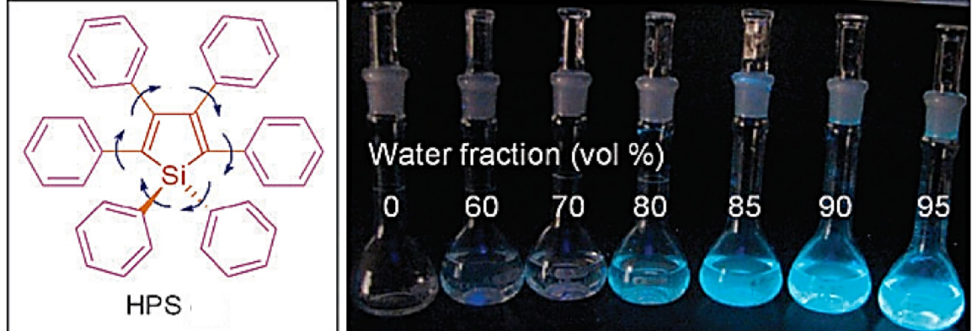
Figure 2. Photograph of hexaphenylsilole (HPS) representing aggregation induced emission (AIE) phenomenon. Reprinted from reference [12] with the permission of the Royal Society of Chemistry.